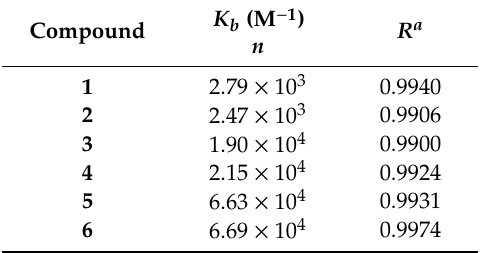
Table 4. Binding constants of compounds 1 – 6 with